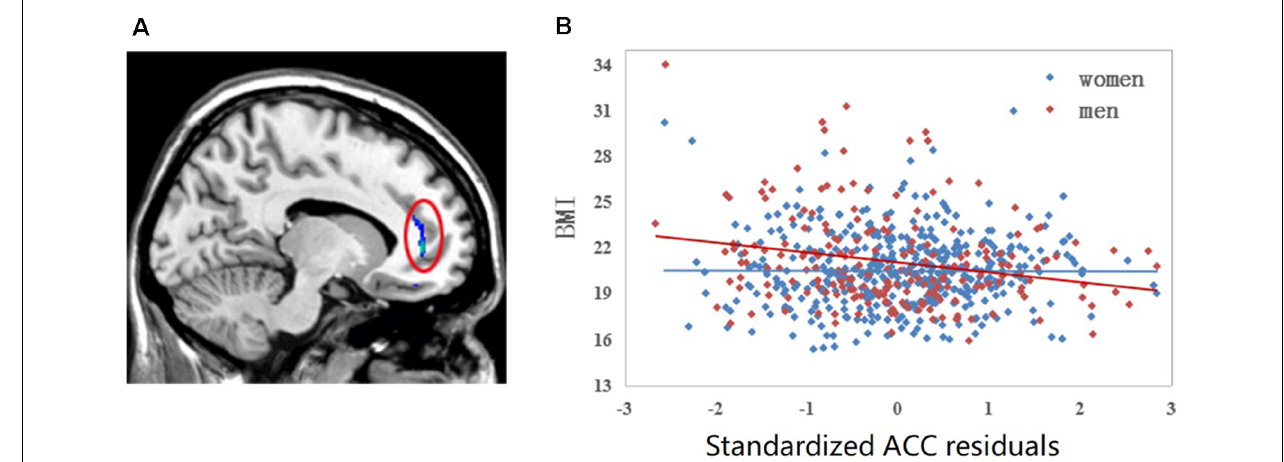
FIGURE 2 | Linear regression of BMI to left anterior cingulate cortex (ACC) volume. (A) Colorful cluster in the red ellipse is located on the left ACC where we detected significant sex by BMI interaction effect family-wise error (FWE; P < 0.05, voxel level). (B) Scatter plot of left ACC is shown. The correlation between BMI and the gray matter volume (GMV) of left ACC is different between men and women after controlling for the whole GMV and age. For men sample, r = − 0.229, P = 0.001; for women sample, r = − 0.004, P = 0.933.